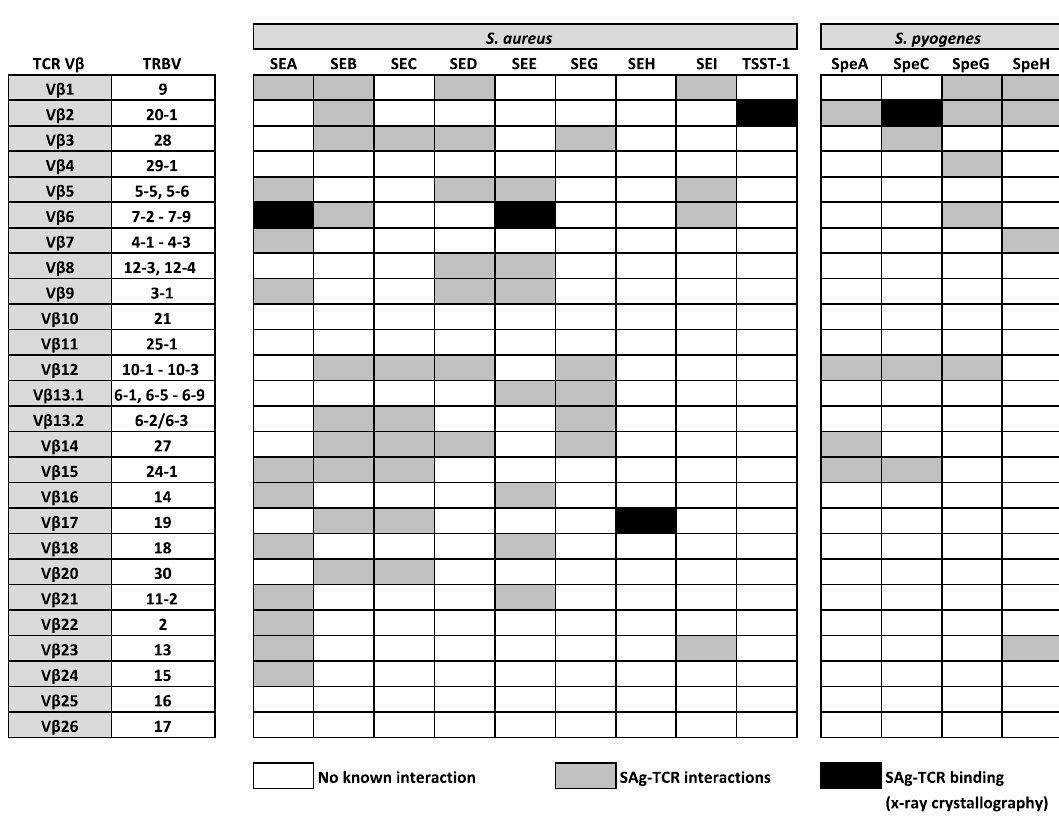
Figure 2. Established interactions between well characterised SAgs from S. aureus and S. pyogenes and human TCR β -chain variable (TRBV) regions.The ability for SAgs to drive cellular dysfunction or deletion in T cell populations is highly affected by HLA class II polymorphisms [260], which